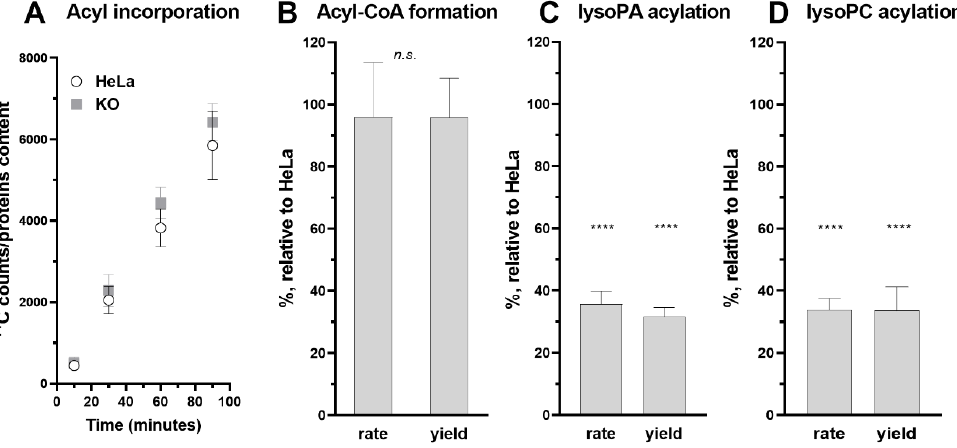
Figure 6. Decrease activity of the lipid acylating enzymes. ( A ) . HeLa and ACBD6.KO cells, grown in 96-well plates, were exposed to 5 µ M [ 14 C]C 16:0 for the indicated times (10 to 120 min). Incorporation of the radiolabel was quantified with a scintillation counter and is reported relative to the protein content, quantified with SRB staining. Error bars represent the standard deviations of values obtained from 8 measurements. ( B – D ). HeLa and ACBD6.KO cells were grown in T75 flasks. Cells were harvested, lysed, and debris was removed by centrifugation. ( B ), the rate of esterification of [ 14 C]C 16:0 (10 µM) into [ 14 C]C 16 -CoA in the presence of ATP, CoASH and of 8 µg protein lysate was determined from 0 to 10 min. Values obtained with ACBD6.KO are reported relative to the values obtained with HeLa. In ( C ), acylation of lysoPA (10 µM) by 20 µg protein lysate was monitored from 0 to 10 min. In ( D ), acylation of lysoPC (10 µ M) by 8 µ g protein lysate was monitored from 0 to 16 min. In each assay, the amount of product formed (yield) was calculated at the last time point. Error bars in ( B – D ) represent the standard deviations of values obtained from 6 measurements: n.s., non-significant; ****, p <